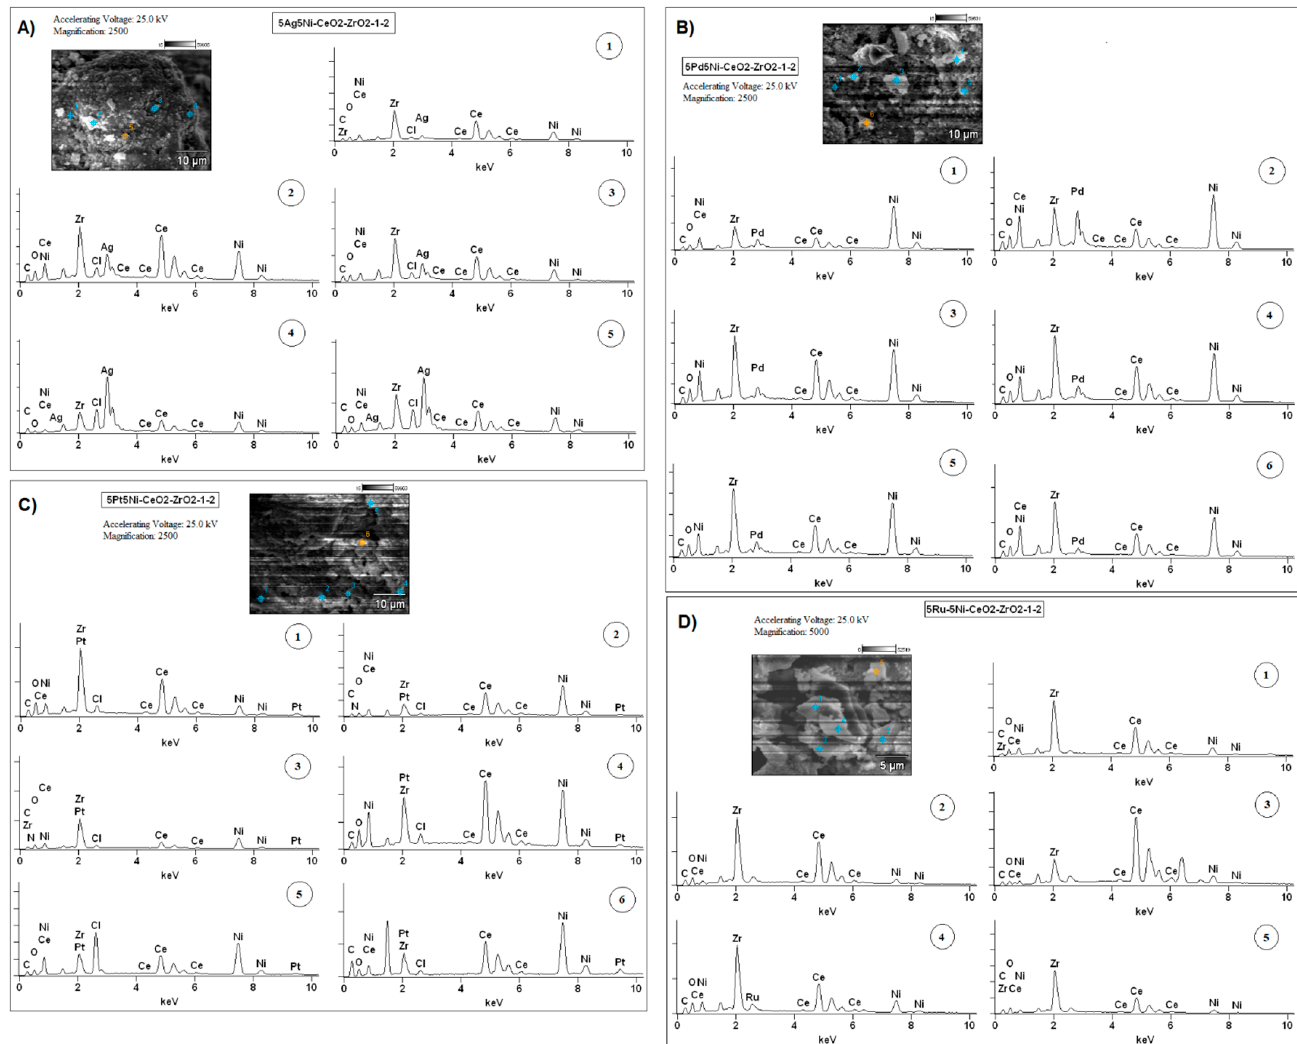
Figure 9. ( A ) SEM image and EDS spectra collected from the marked points analysis recorded for reduced bimetallic 5%Ag ‐ 5%Ni/CeO 2 ∙ ZrO 2 (1:2) catalyst; ( B ) SEM image and EDS spectra collected from the marked points analysis recorded for reduced bimetallic 5%Pd ‐ 5%Ni/CeO2 ∙ ZrO 2 (1:2) catalyst; ( C ) SEM image and EDS spectra collected from the marked points analysis recorded for reduced bimetallic 5%Pt ‐ 5%Ni/CeO 2 ∙ ZrO 2 (1:2) catalyst; ( D ) SEM image and EDS spectra collected from the marked points analysis recorded for reduced bimetallic 5%Ru ‐ 5%Ni/CeO 2 ∙ ZrO 2 (1:2) catalyst.